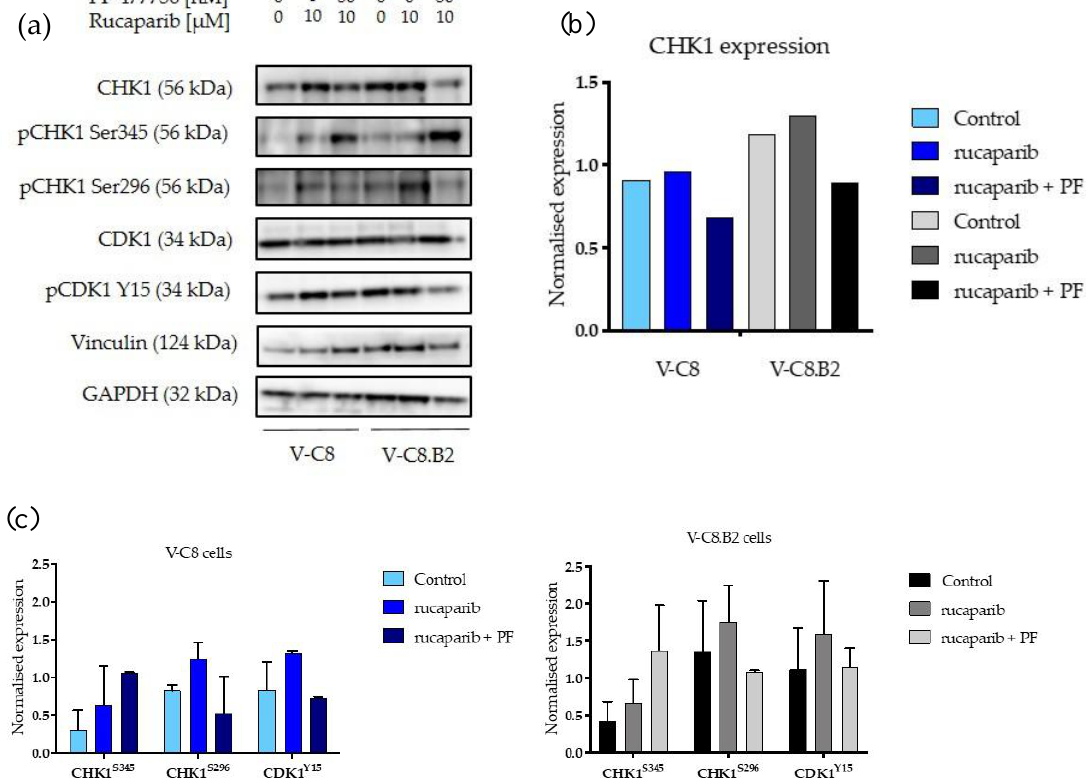
Figure 3. CHK1 expression, activation by rucaparib, and inhibition by PF-477736 in BRCA2 mutant and corrected cells. Cells were exposed for 24 h to DMSO, rucaparib, or rucaparib and PF-477736 and analysed for pCHK S345 , CHK1, and pCDK1 Tyr15 . Vinculin was used as a loading control for pCHK S345 , CHK1, pCDK1 Tyr15 and CDK1, and GAPDH was used as the loading control for CHK1 S296 ( a ) Western blot from a single representative experiment. ( b ) Densitometry was calculated using Syngene software of CHK1 expression normalised to Vinculin. ( c ) Normalised densitometry of phosphorylated CHK1 and CDK1. Data are the mean and standard deviation of three individual experiment.